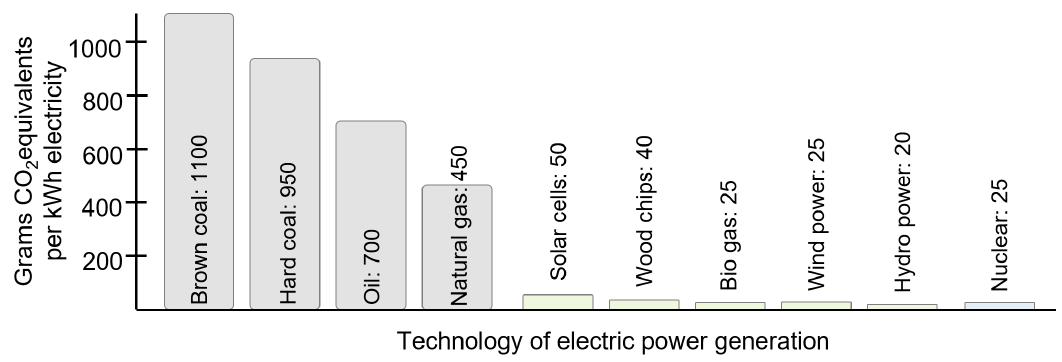
Figure 3. CO 2 -equivalent-emission impacts of selected technologies of electric power generation [6– 9].